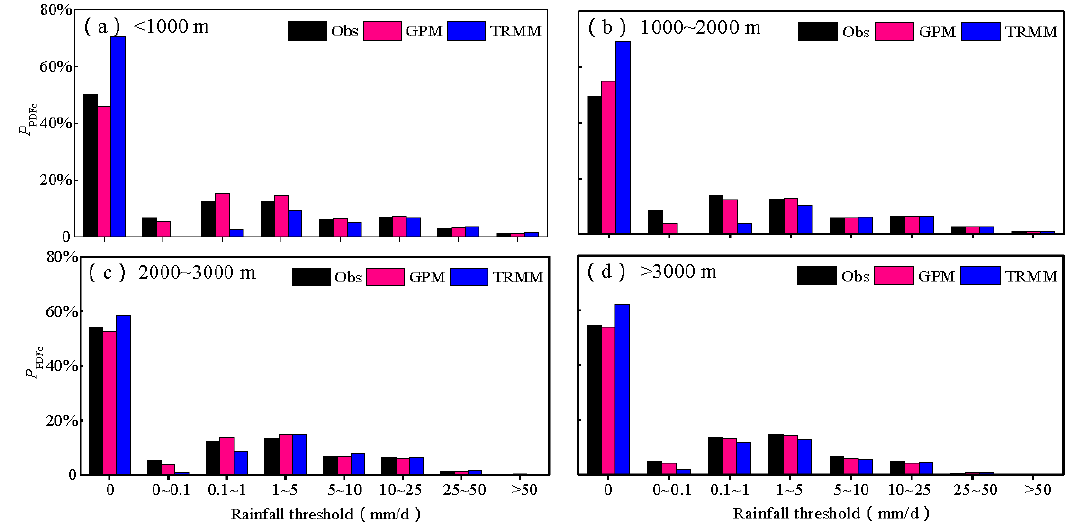
Figure 9. P PDFc of IMERG v5 and 3B42 v7 at different altitudes. ( a ): < 1000 m; ( b ): 1000~2000 m; ( c ): 2000~3000 m; ( d ): > 3000 m)